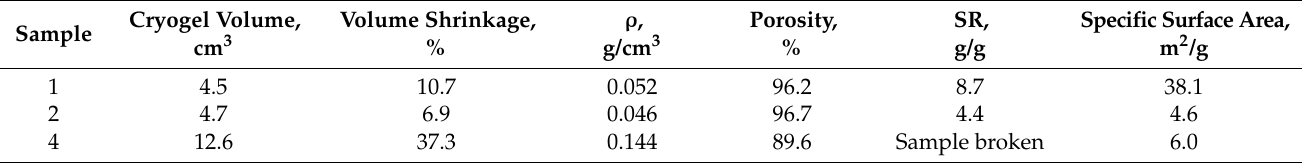
Table 2. Characterization of intact cylindrical